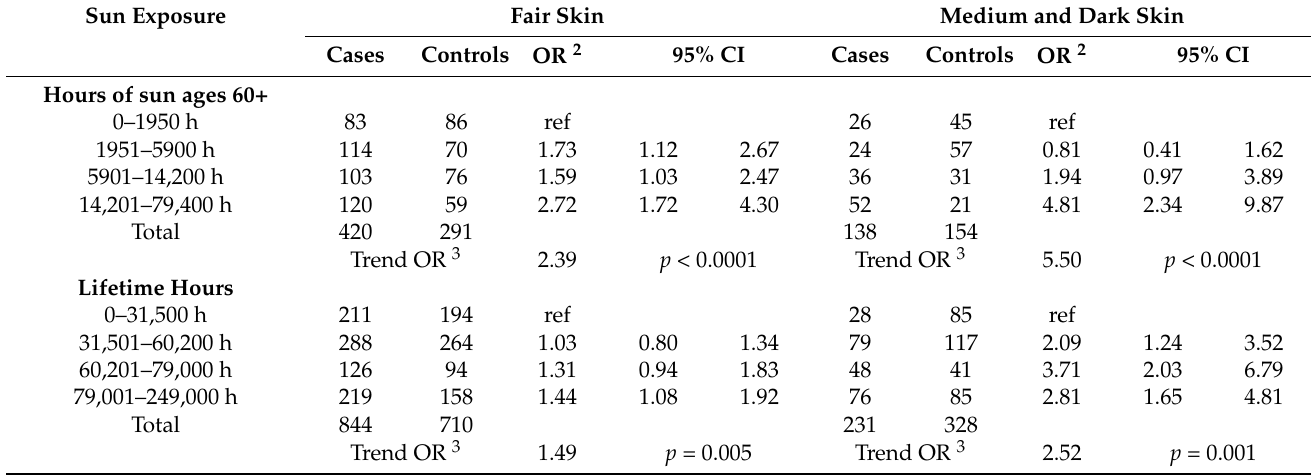
Table 3. Lifetime and age 60+ h of sun exposure between March and October among 1076 melanoma cases and 1039 population-based controls in Iowa stratified by self-reported skin color 1